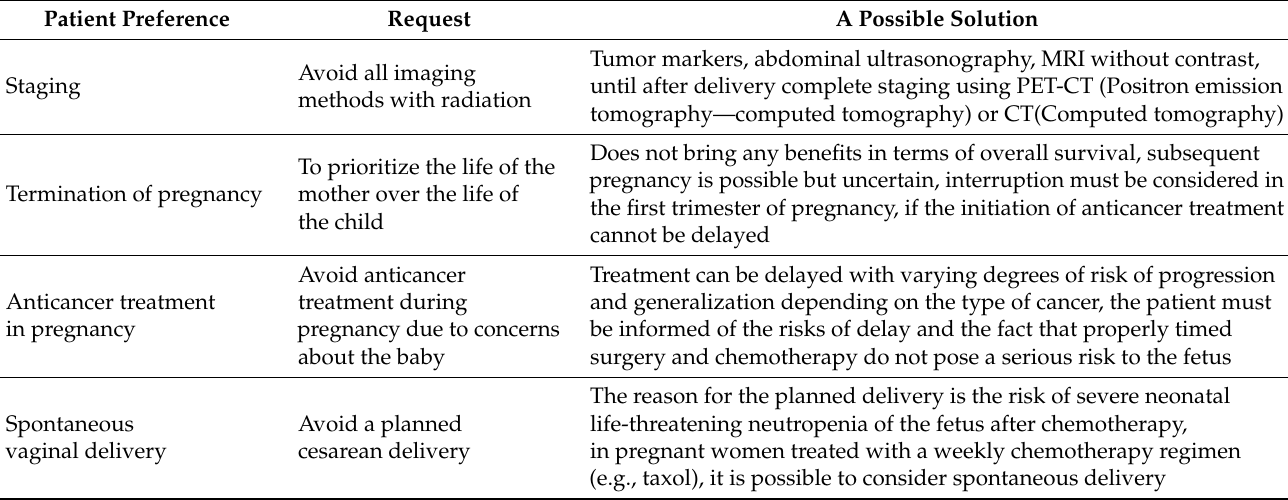
Table 4. Personalization according to patient